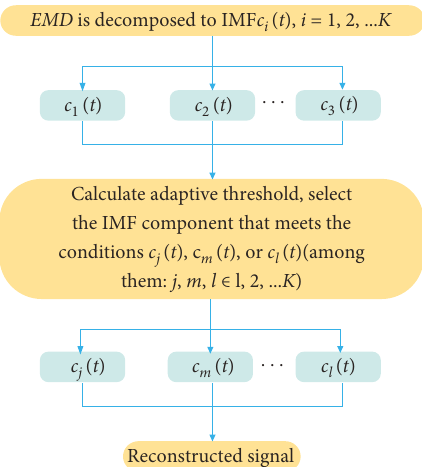
Figure 3: Flow chart of EEMD